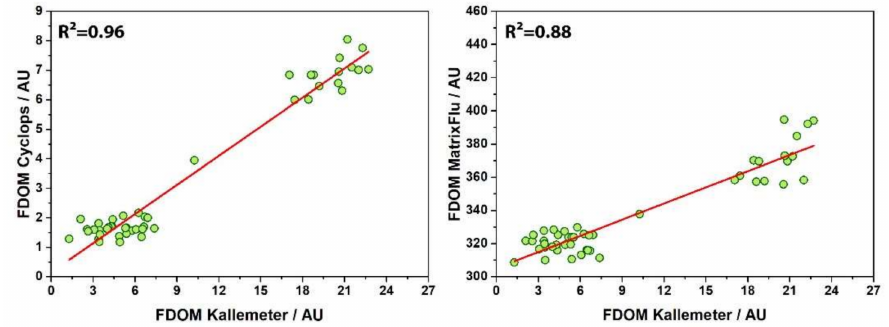
Figure 9. Comparison of extracted ‘Kallemeter’ bulk fluorescence signal against FerryBox FDOM Cyclops-7-U sensor ( left panel ) as well as the corresponding channel of the MatrixFlu-UV ( right panel ). Red lines represent the results of a linear